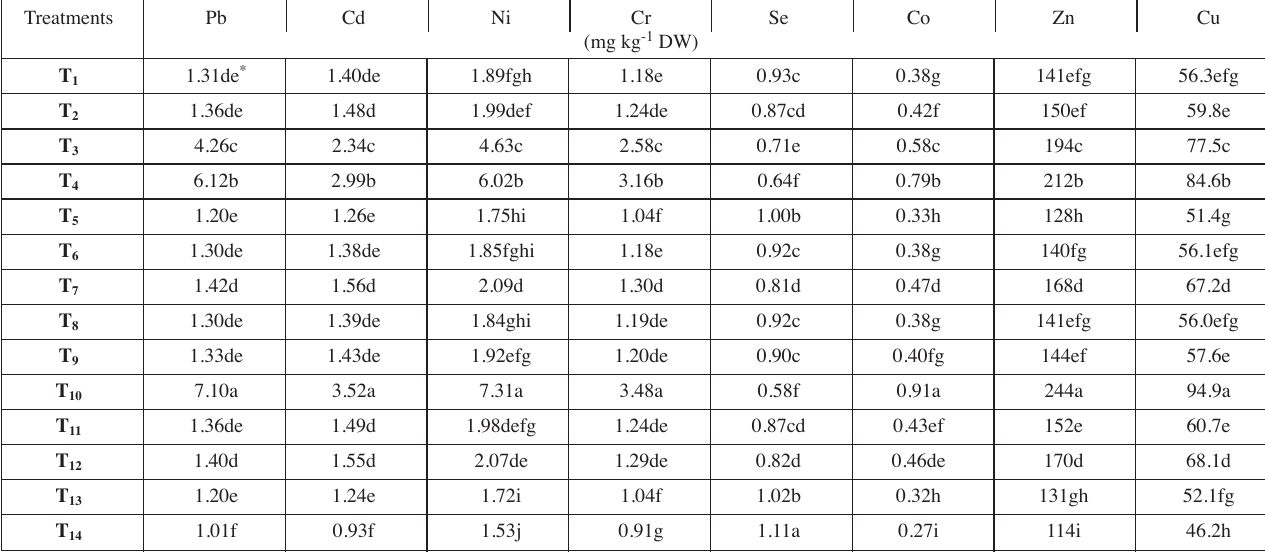
Tab. 7: Effect of N-fertilizer form applications on the concentrations of heavy metals [lead (Pb), cadmium (Cd), nickel (Ni), chromium (Cr), selenium (Se), cobalt (Co), zinc (Zn), and copper (Cu)] in harvested grains of wheat plants grown under saline soil conditions Treatments